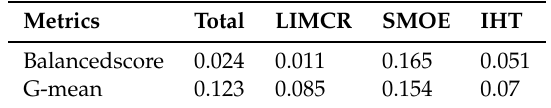
Table 13. p -Value of Friedment test between different classifiers for resampling methods.